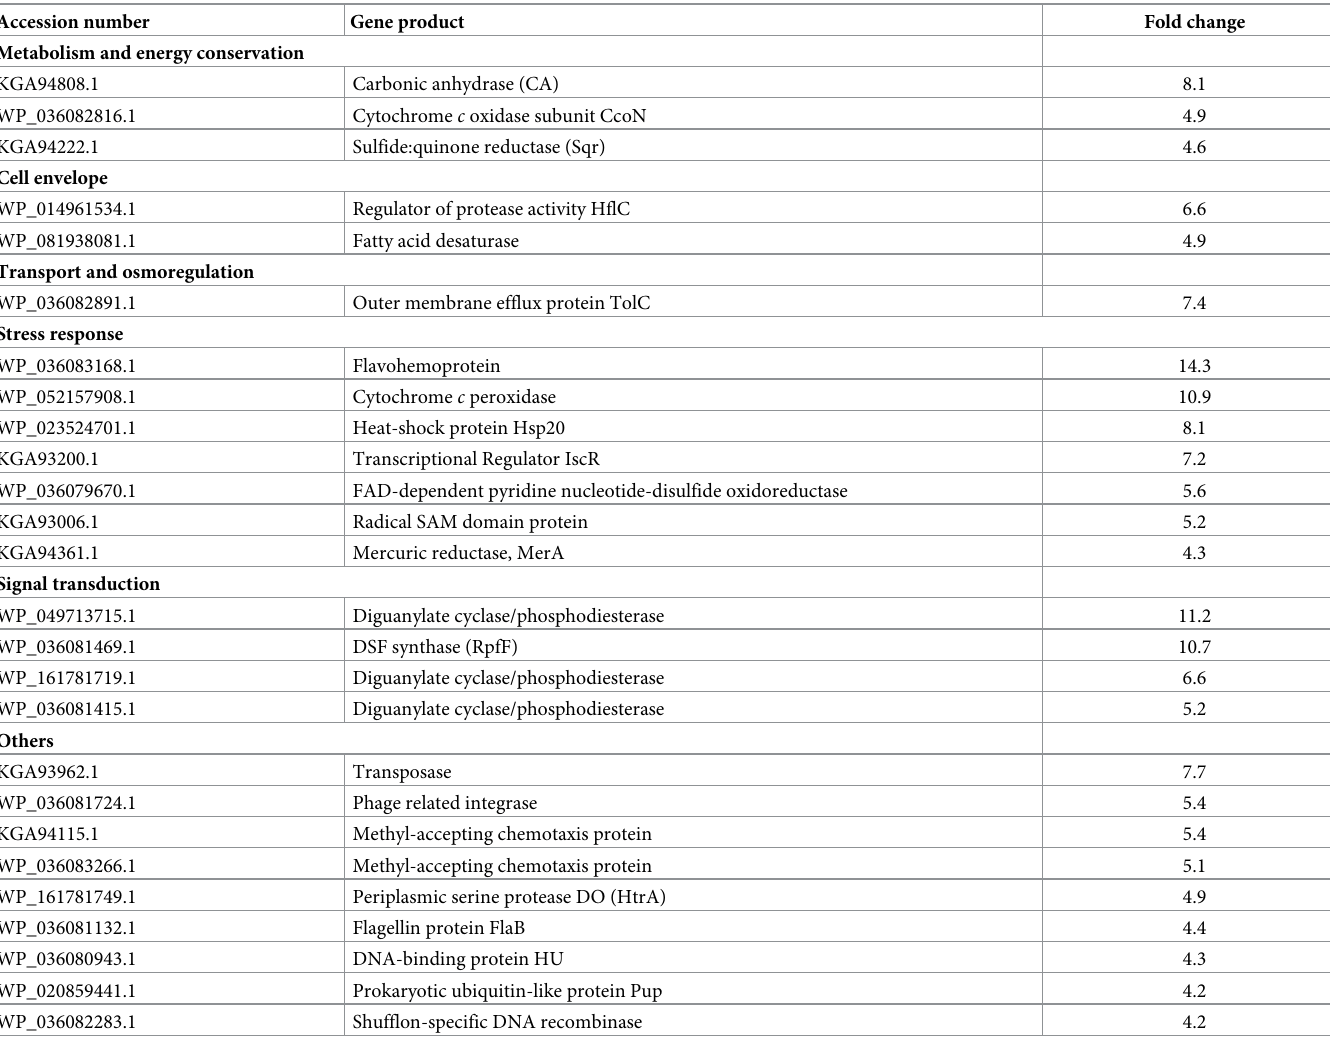
Table 2. Up-regulated genes in L . ferriphilum DSM 14647 adapted to 180 mM NaCl in relation to non-adapted non-exposed control